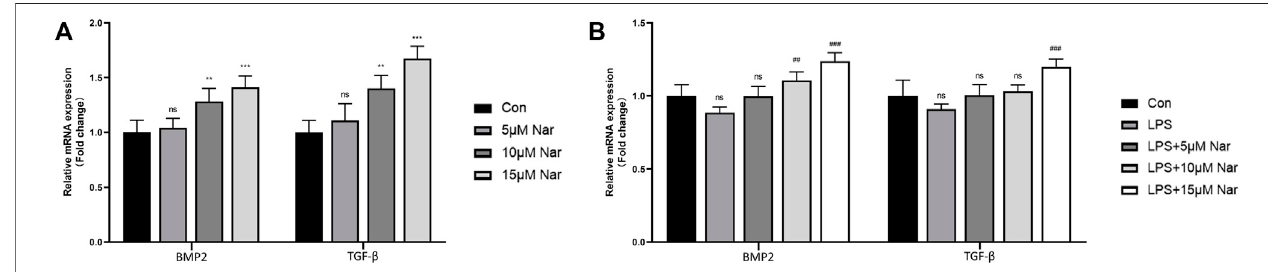
FIGURE 4 | Effects of naringenin on the expression of BMP-2 and TGF- β in macrophages. The gene expressions of BMP-2 and TGF- β in response to naringenin under non-in fl ammatory environment (A) and in fl ammatoryenvironment (B) measured byRT-qPCR. n = 4per group. Dataare expressed as mean ±SD. * # p < 0.05;